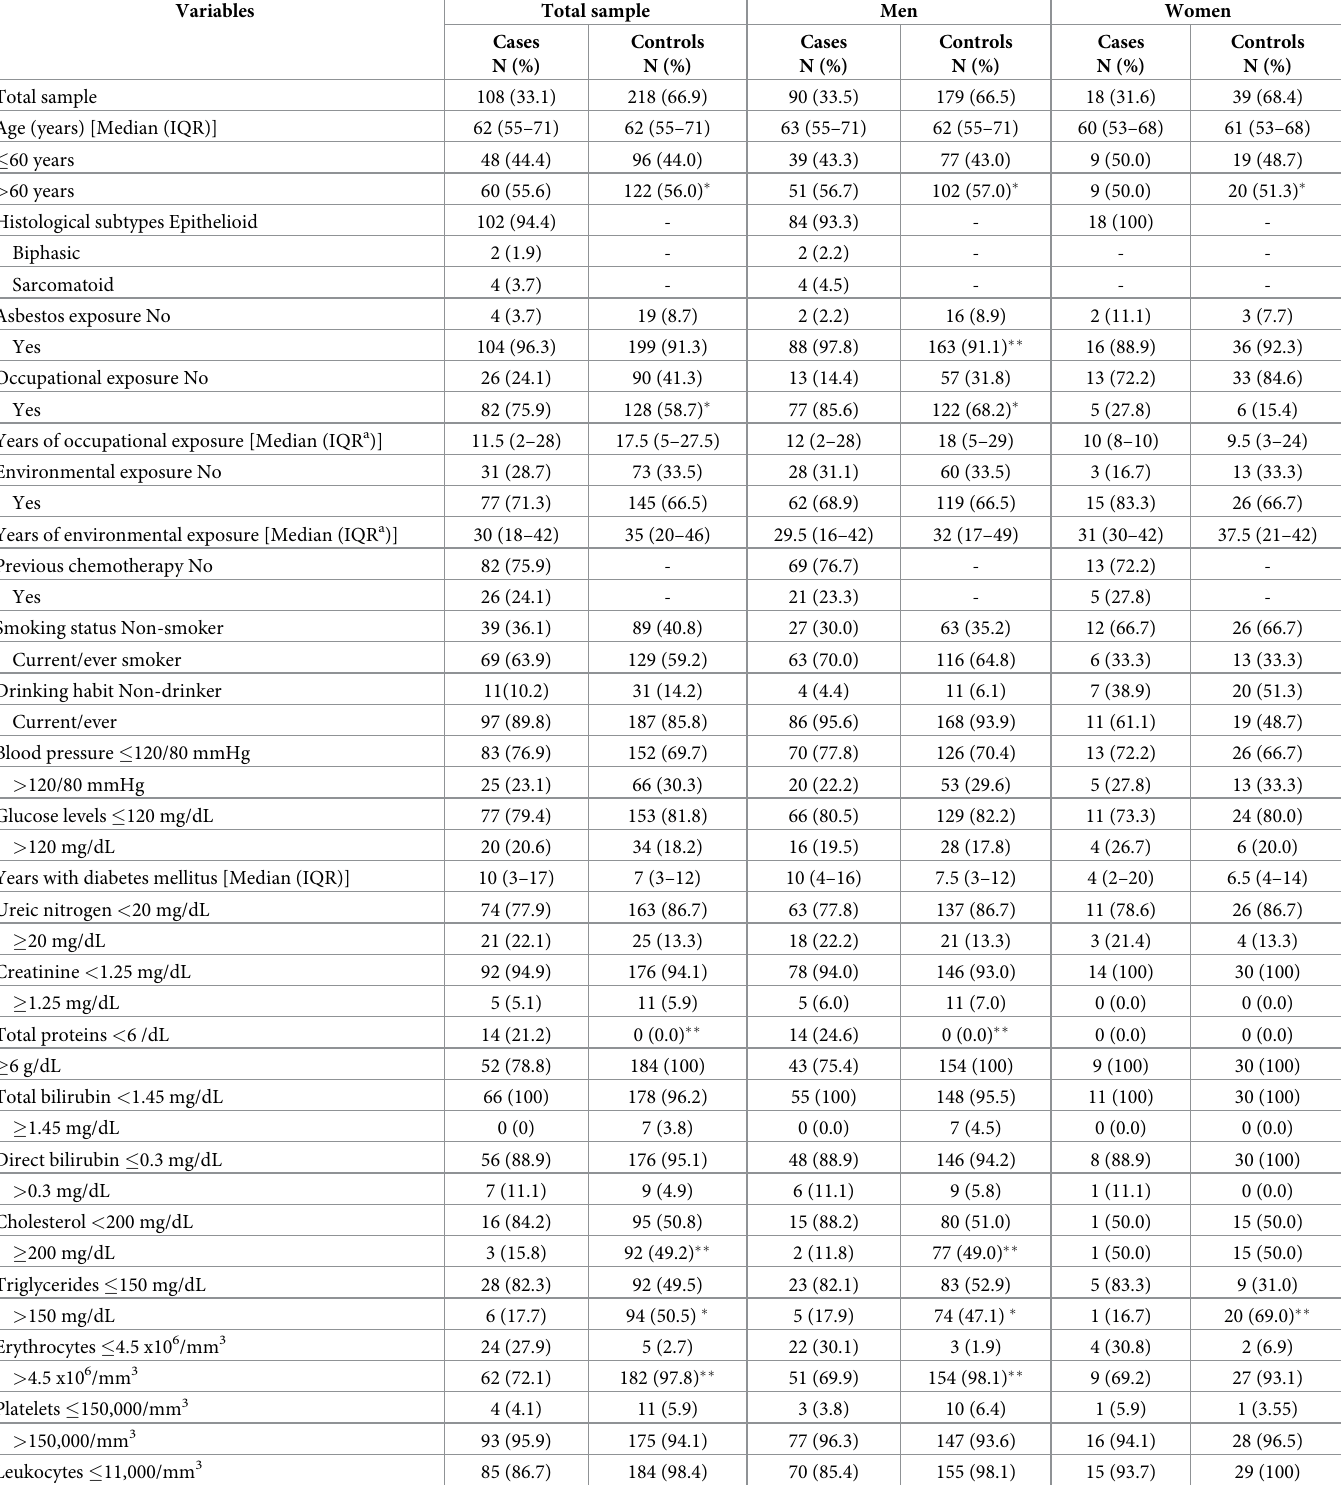
Table 1. Main characteristics of malignant pleural mesothelioma cases and healthy controls by gender in a Mexican